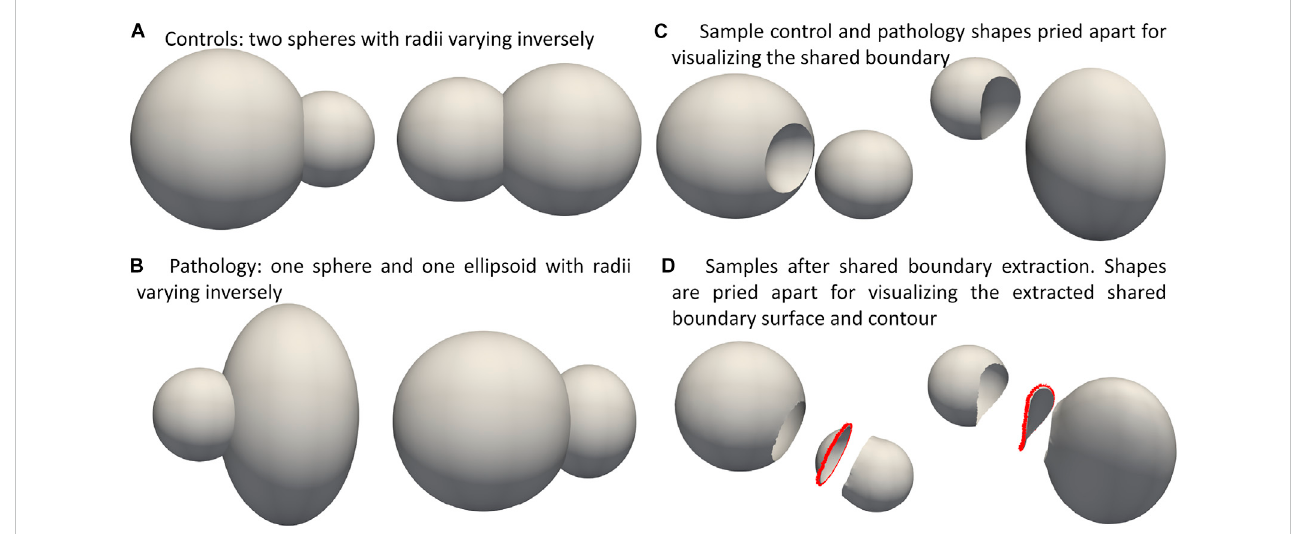
FIGURE 3 Synthetic Peanut Dataset: Surface meshes representing the two groups included in the peanut dataset- (A) Controls group: two spheres with varying radii, (B) pathalogical changesare emulatedbychangingone ofthespherestoellipsoid. (C) Samplesfrom thecontrols andpathalogygroupsshow casing the shared boundarysurface, (D) sampleoutputsobtained after extracting theshared boundarysurfaceand contour.The meshes arepriedapartfor